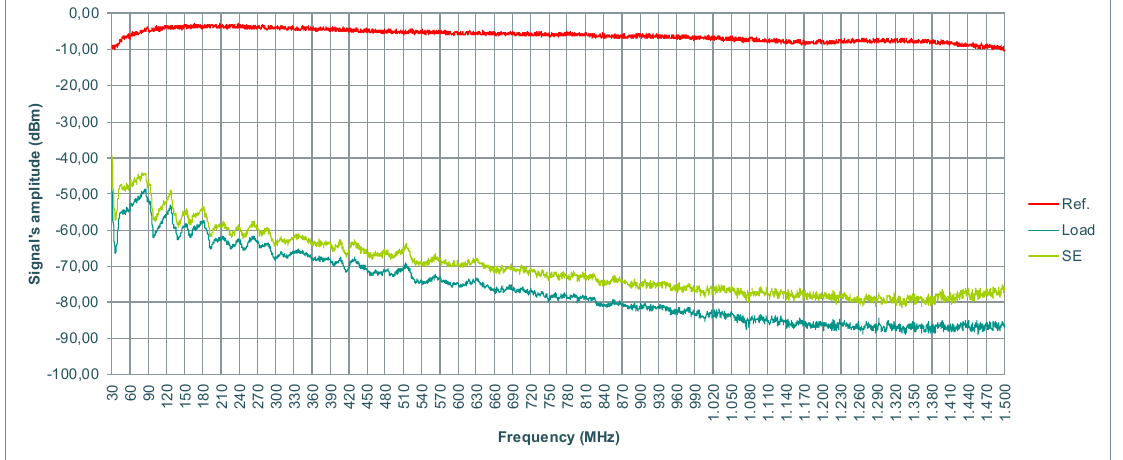
Figure 8. Signal’s amplitude vs. frequency for the CF/Rosin bio-composite.